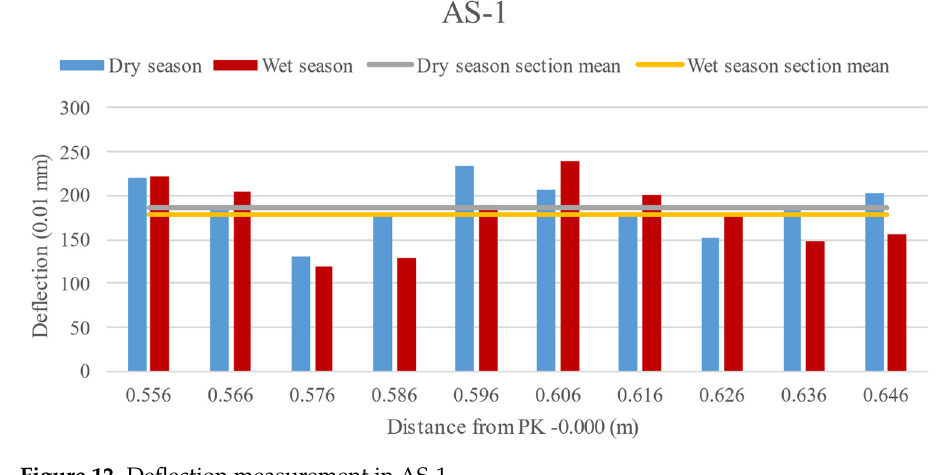
Figure 12. Deflection measurement in AS-1.